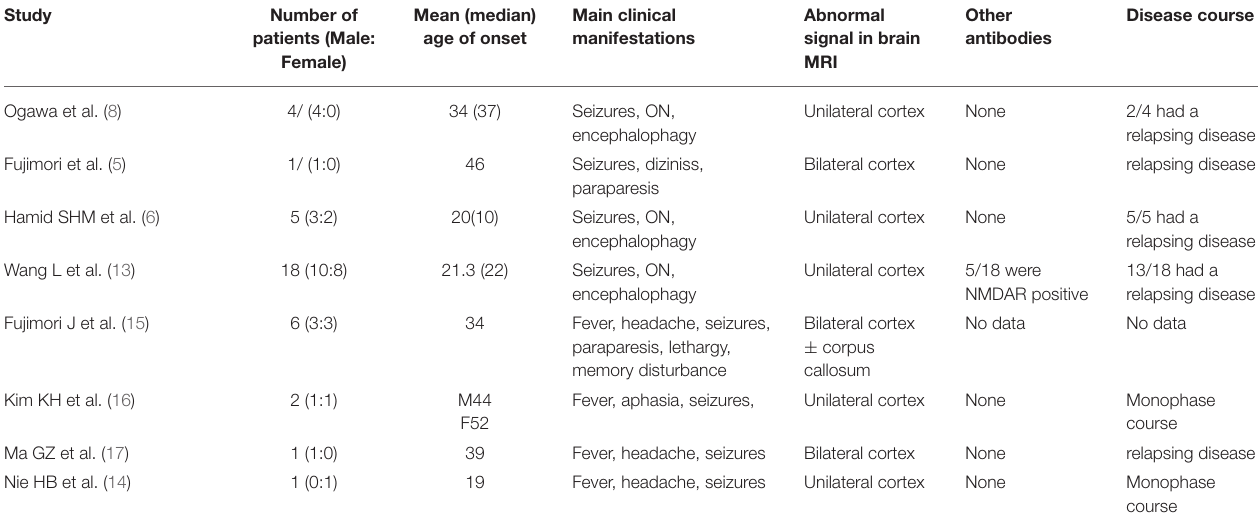
TABLE 1 | Summary of the case reports about MOG-IgG associated cortical encephalitis. Study Number of Mean (median) Main clinical patients (Male: age of onset